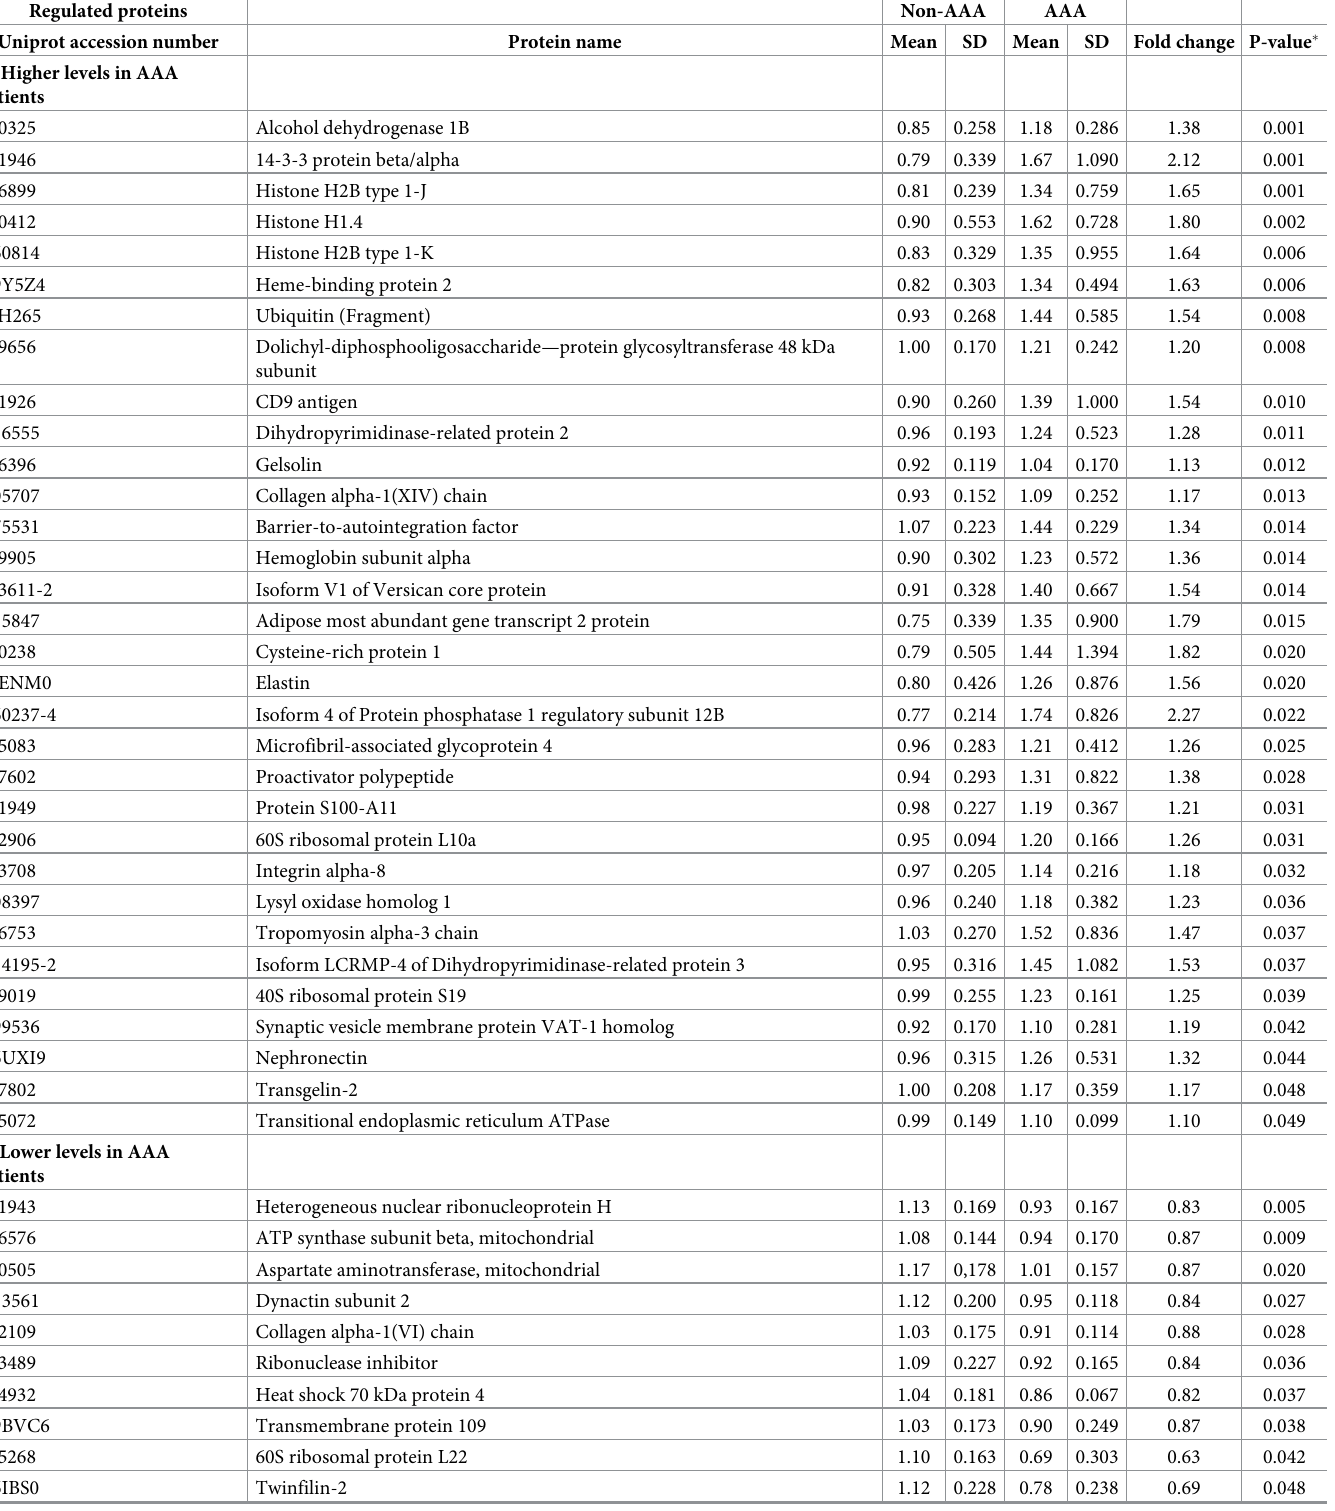
Table 2. Comparison of protein levels in the internal mammary artery between AAA-cases and